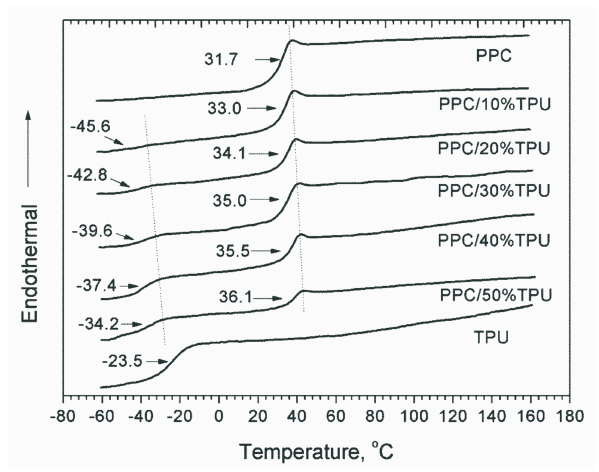
Figure 3. DSC curves of neat PPC, neat TPU and PPC/TPU blends.